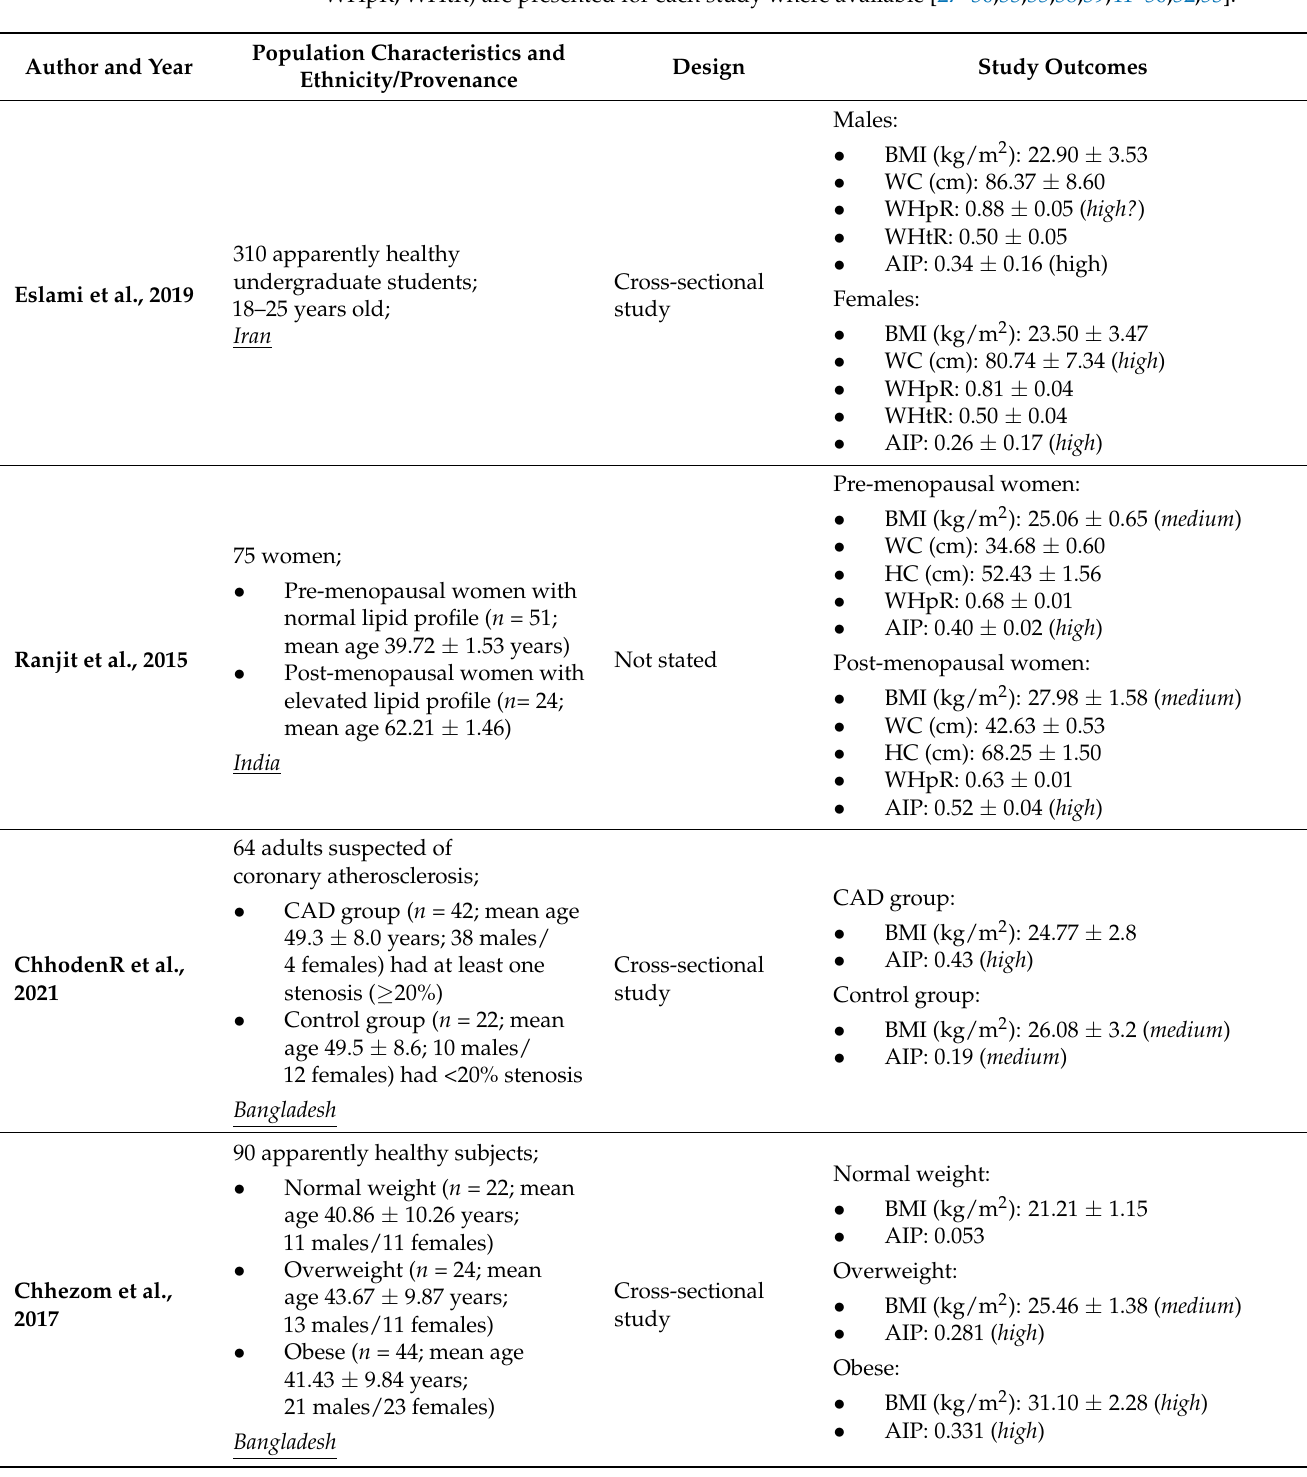
Table 3. Review of studies interlinking anthropometric parameters and AIP. Author, year, subject characteristics, study design, primary outcomes, and other study outcomes of interest (BMI, WC, WHpR, WHtR) are presented for each study where available